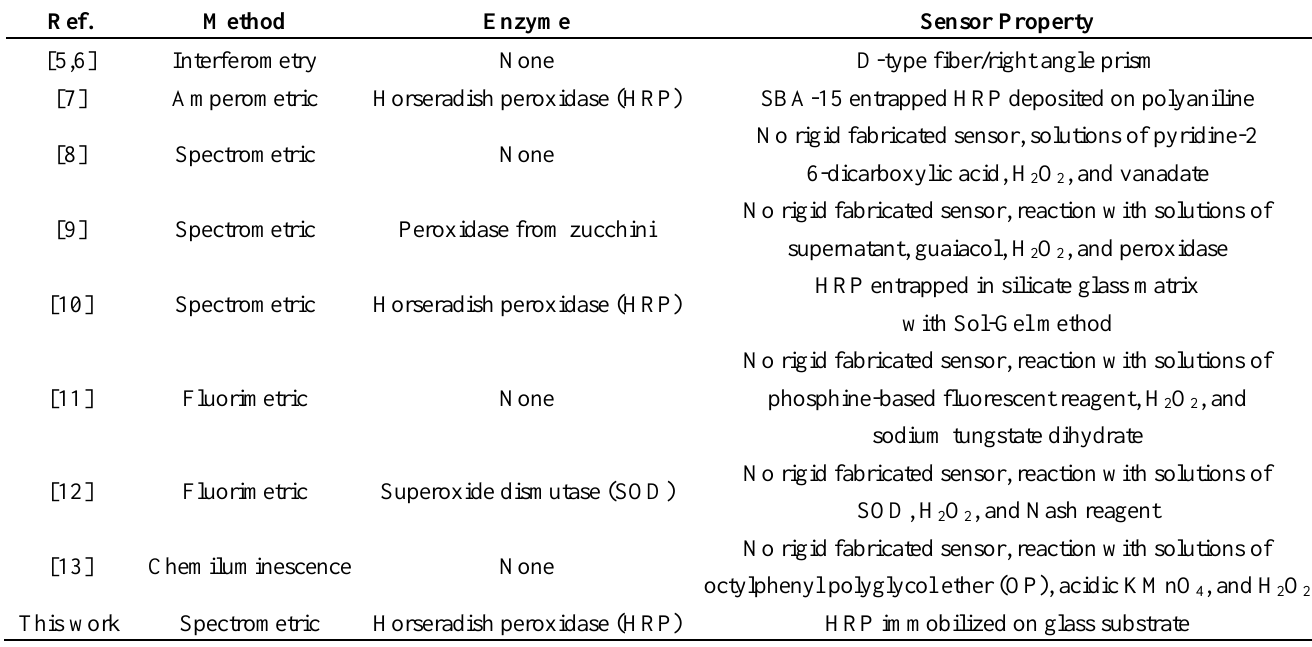
Table 1. Comparisons of the proposed